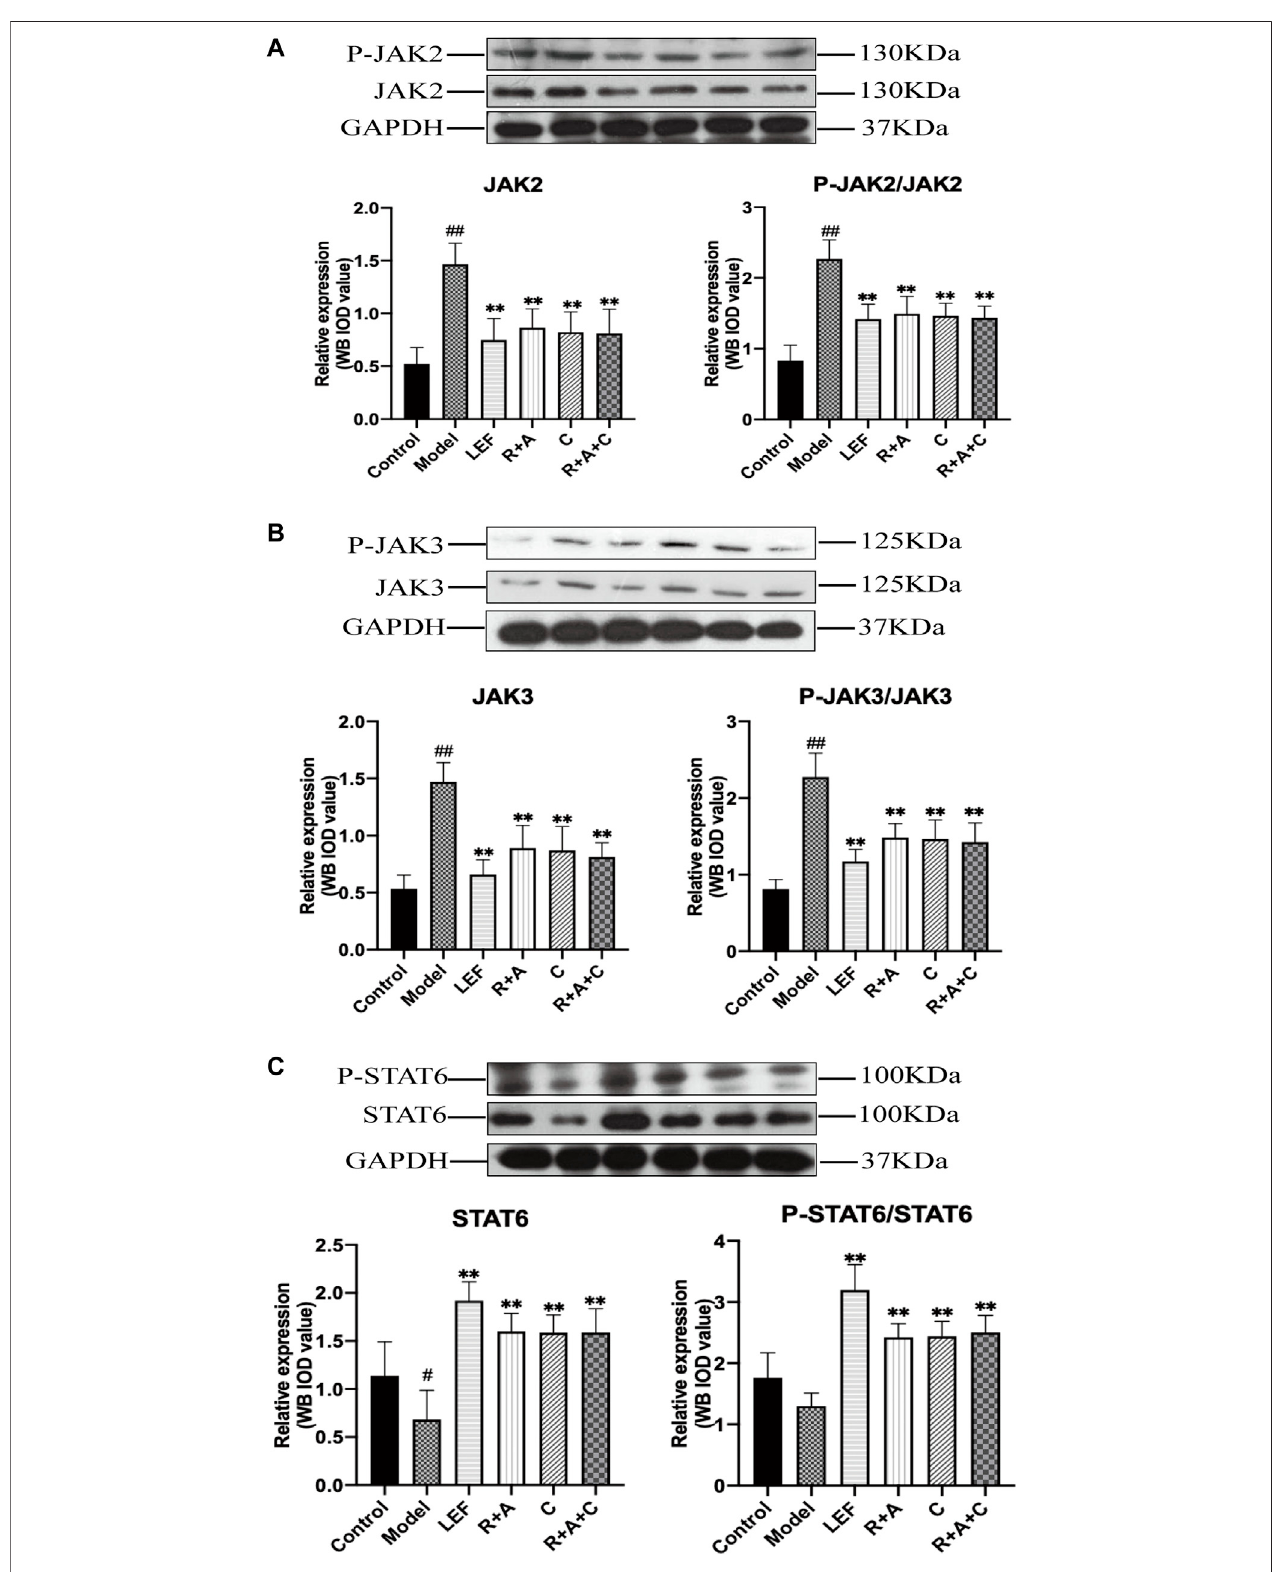
FIGURE9| The levelsofkeymoleculesintheJAK-STATsignalingpathwayofcontrolandCIAmice. (A) TheproteinexpressionlevelsofJAK2andP-JAK2. (B) Theprotein expressionlevelsofJAK3andP-JAK3. (C) TheproteinexpressionlevelsofSTAT6andP-STAT6.Resultsarepresentedinabarchart.Theresultsarepresentedinabarchart.Data are presented as mean ± SD ( n = 3); # p < 0.05, ## p < 0.01, compared with the normal group; * p < 0.05, ** p < 0.01, compared with the model group.